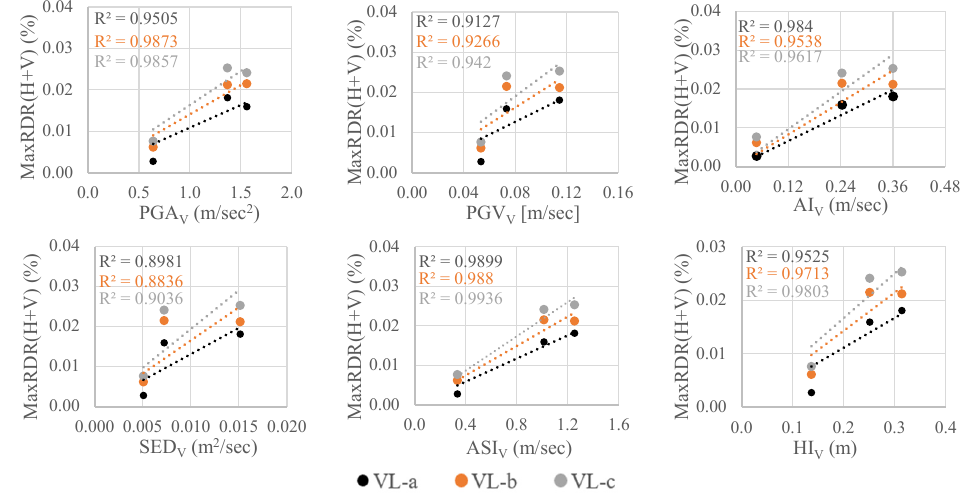
Figure 21. Correlations between the GMPs of the V components (GMP V ) and the maximum RDR obtained on the case–study structure from the simultaneous application of the H and V components, maxRDR(H + V). In each image, with the sole exception of the PGA V plot, from left to right, earthquakes #3, #1, and #2; in the PGA V plot ( top left ), from left to right, earthquakes #3, #2, and #1.